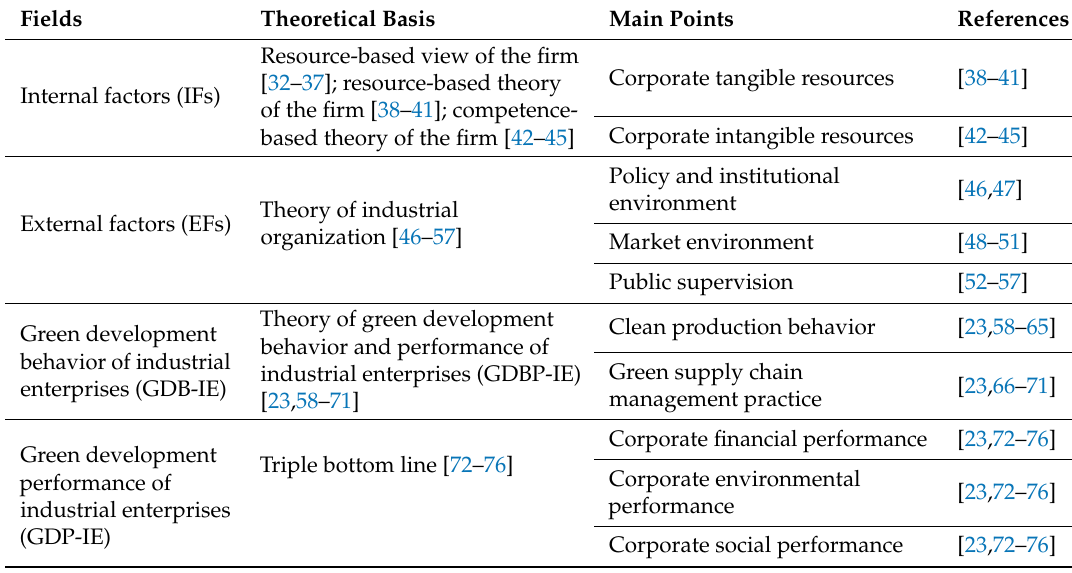
Relevant literature on the green development (GD) behavior and performance of industrial